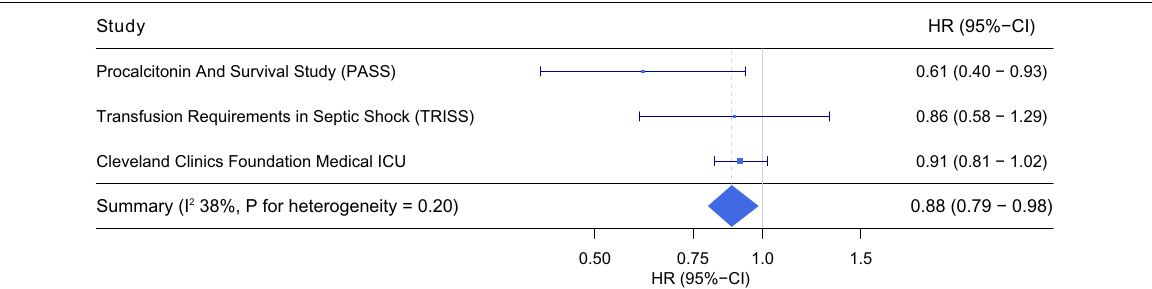
Fig. 3 The effect of blood B versus non‑blood type B on 30‑day mortality in three independent ICU cohorts—individual patient data meta‑analysis